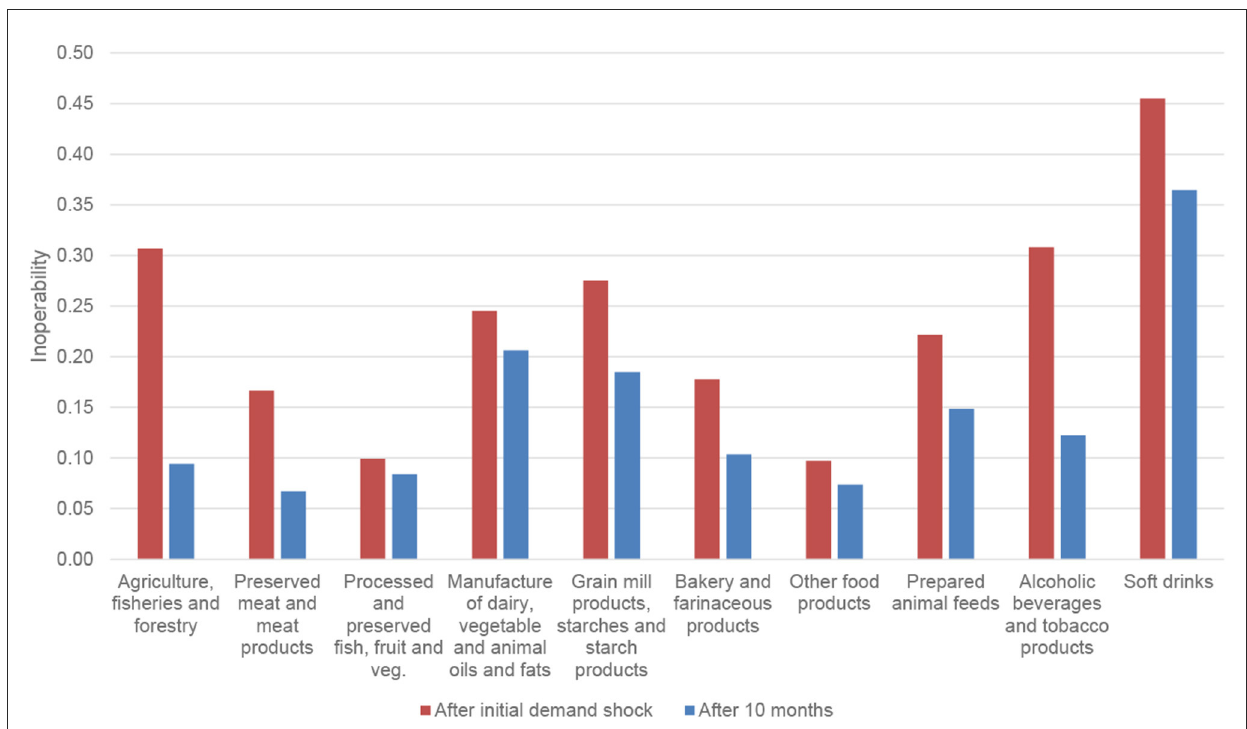
FIGURE7 Initial and after 10 months of inoperability for agrifood and related sectors. Source: Own computation based on the Scottish input–output tables from 1998 to 2019.